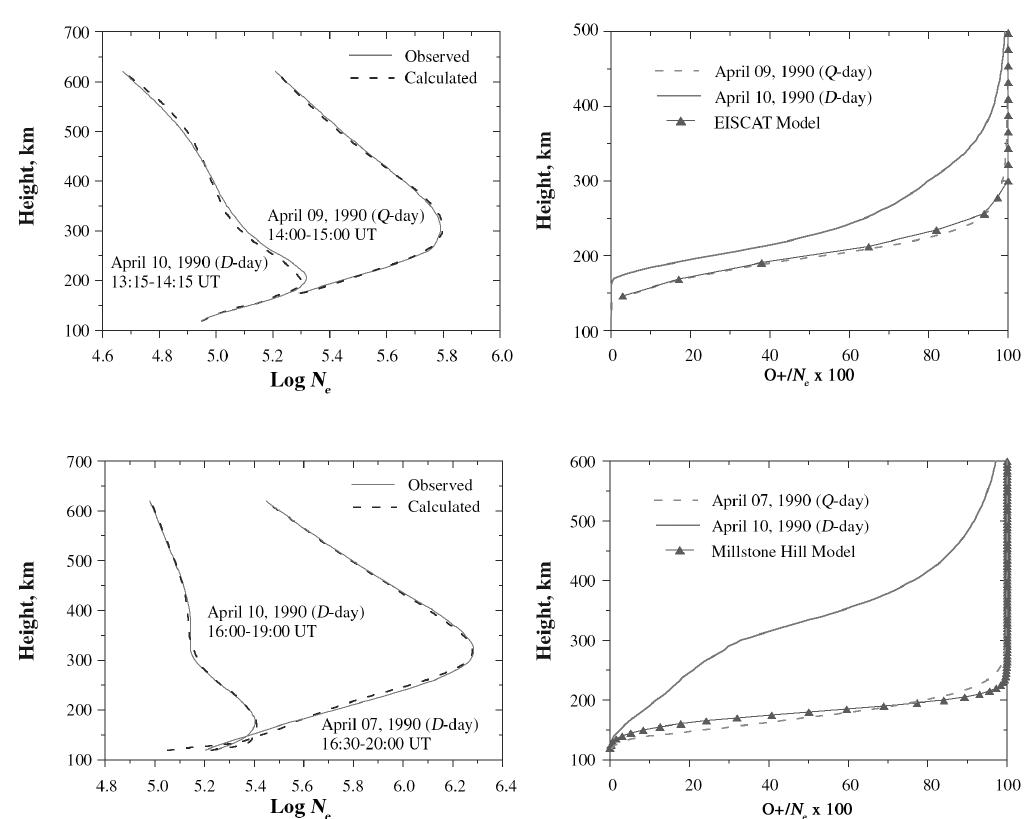
Fig. 4.8. Observed and calculated at EISCAT ( top ) and Millstone Hill ( bottom ) N e ( h ) profiles for disturbed April 10, 1990 and quiet reference days. Right-hand panels – calculated and standard model O + / N e profiles at the two locations. F 2-region is seen to be strongly enriched with molecular ions for the disturbed day, while the cal- culations are close to the models for quiet